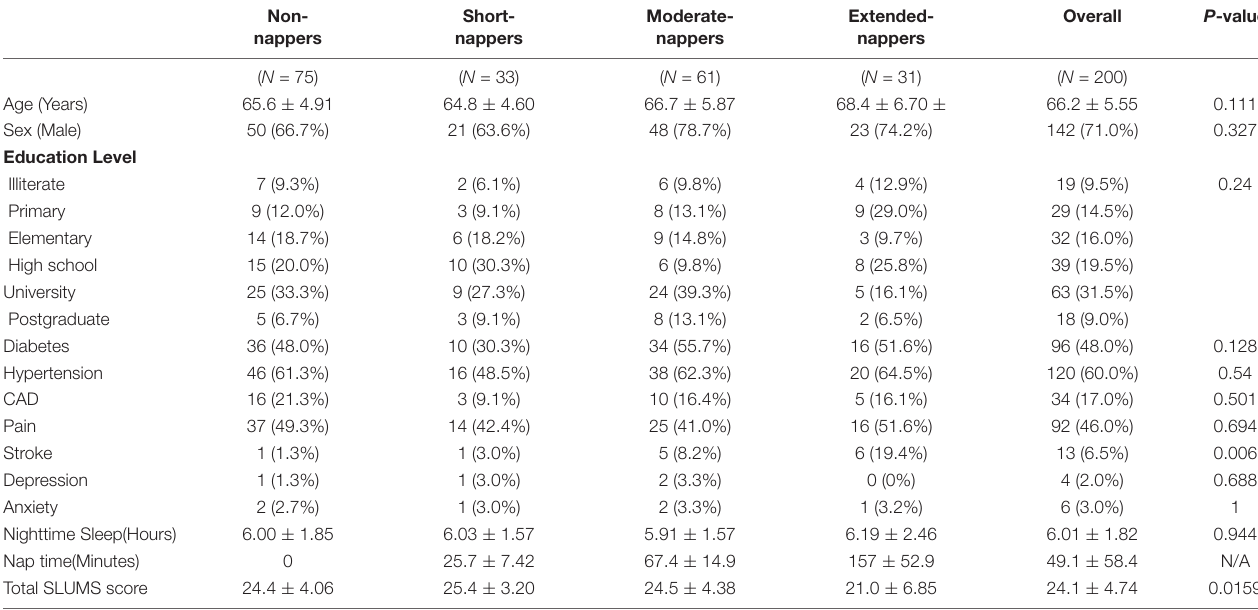
TABLE 1 | Demographic and cognitive scores among the participants.